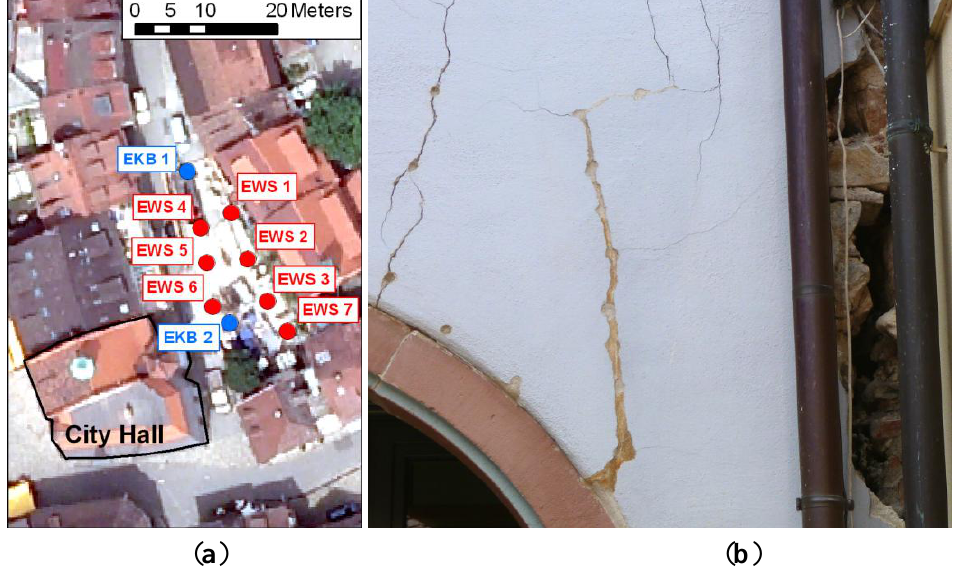
Figure 2. ( a ) Location of the seven heat exchanger boreholes (red) and the two exploration wells (blue) next to the city hall sketched on an orthophoto (acquired by the State Survey Office of Baden-Württemberg). ( b ) One of the affected buildings in Staufen with large cracks (picture by C. Lubitz, 23 August